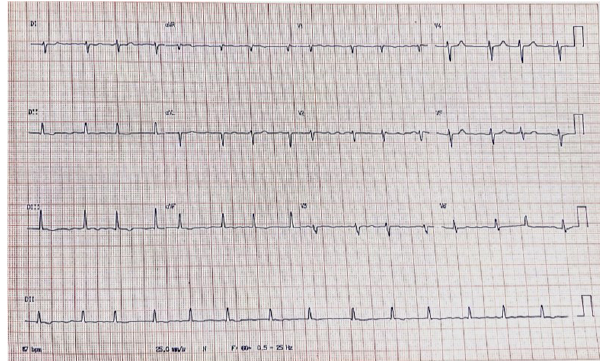
Fig. 1 - . Eletrocardiogram demonstrating atrial fibrillation with an axis deviation to the right.